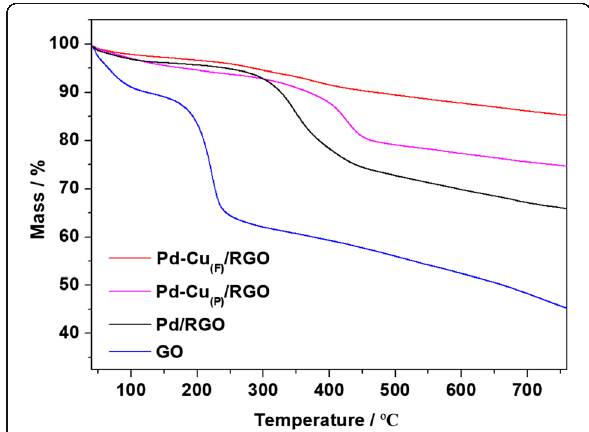
Fig. 6 TGA curves of Pd-Cu (F) /RGO, Pd-Cu (P) /RGO, Pd/RGO, and GO from 40 to 780 °C in air